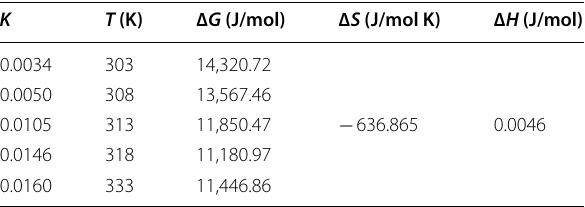
Table 4 Thermodynamics values for the adsorption